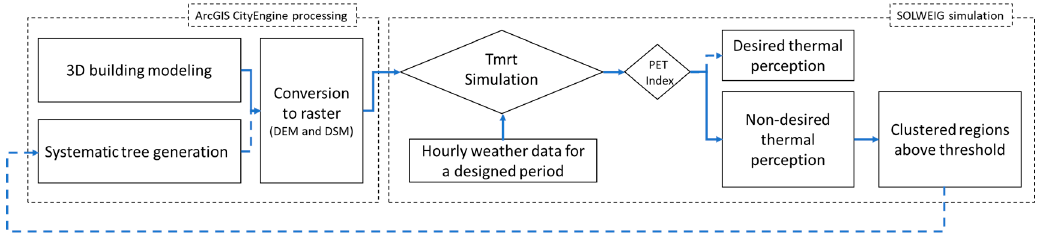
Figure 3. The flowchart of outdoor thermal assessment and improvement via systematic tree generation as the passive heat mitigation strategy.